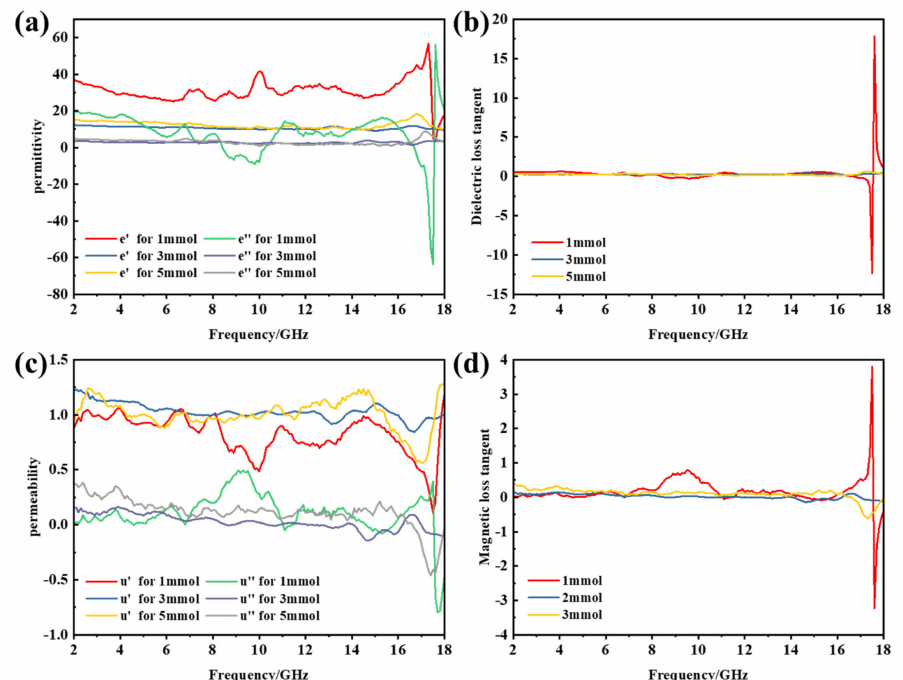
Figure 7. Permittivity and permeability spectra of Fe 3 O 4 /MWCNT composite materials with different Fe 3+ concentrations: ( a ) real part and imaginary part of the permittivity, ( b ) dielectric loss factor, ( c ) real part and imaginary part of the permeability and ( d ) magnetic loss